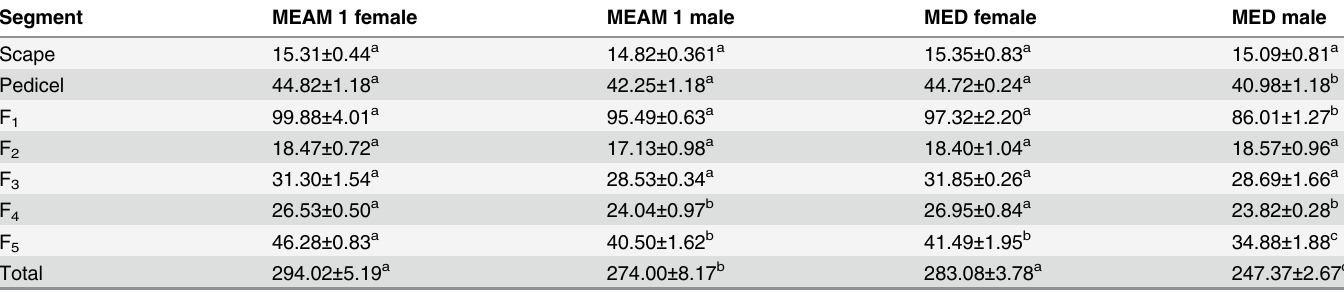
Table 1. Lengths of the scape, pedicel, and flagellum in the two cryptic B . tabaci specie (mean ± SD μ m).